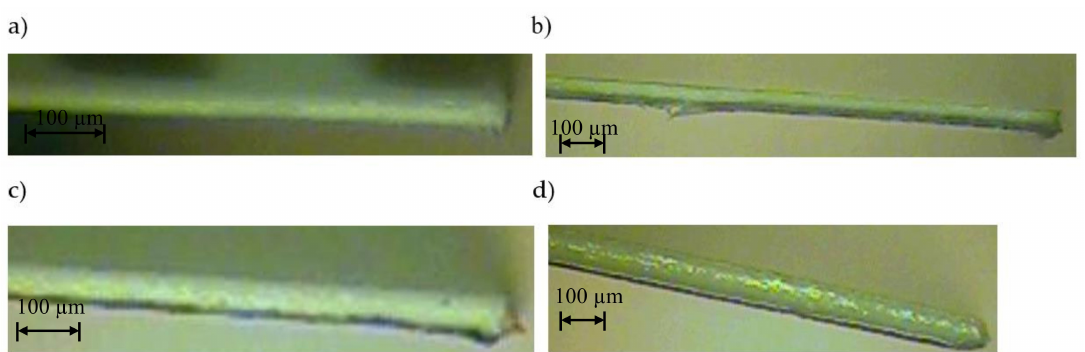
Figure 9. View of the cut surface of foil with thickness: ( a ) t = 50 µ m, ( b ) t = 60 µ m, ( c ) t = 70 µ m, ( d ) t = 80 µ m ( v = 0.751 m / s, f = 85 kHz). Exemplary photos of the cutting surface of the foil with a thickness of t = 70 µ m are shown in Figure 7. A complete separation of the material was obtained for all analyzed cases. For the cutting speed of v = 0.222 m / s, there are visible defects of the cut surface in the form of slivers, fines and debris (Figure 7a). Exemplary photos of the cutting surface of the foil with a thickness of t = 80 µ m are shown in Figure 8. Complete separation was not obtained for cases of cutting at v = 0.751 m / s and UV laser frequency f = 20 kHz and f = 150 kHz. In other cases no defects of the cut edge were